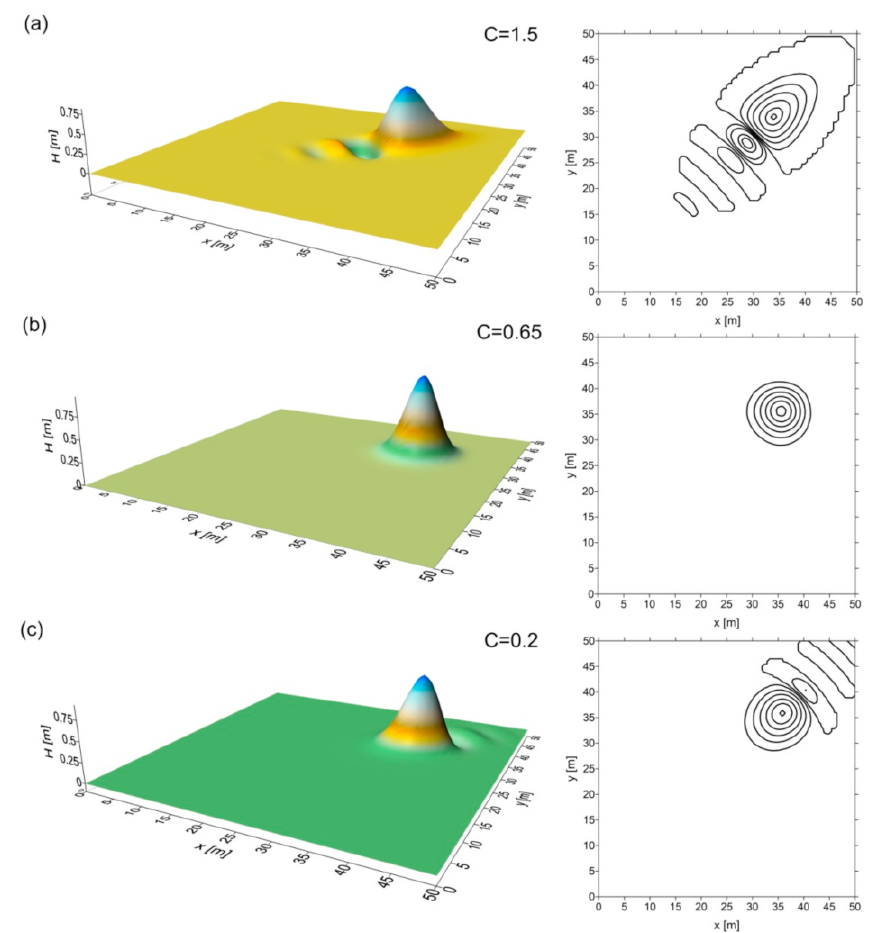
Figure 9. Solution obtained using the 6N mesh with θ = 1/2 and α = 1/3 for various values of the Courant number: ( a ) C = 1.5; ( b ) C = 0.65; ( c ) C =